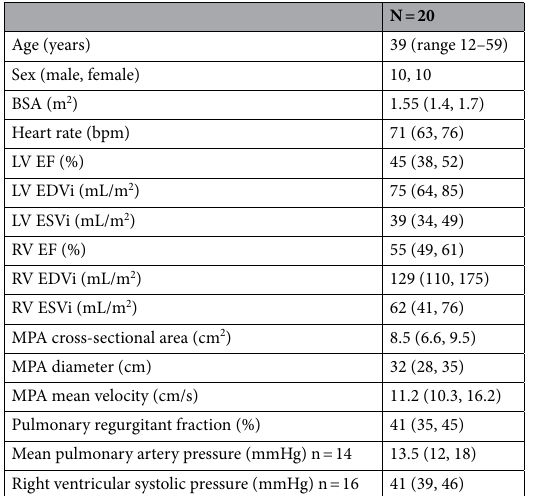
Table 1. Characteristics of 20 patients with repaired Tetralogy of Fallot. Continuous variables were expressed as median and interquartile range (lower, upper). BSA body surface area, LV left ventricular, EF ejection fraction, EDVi end-diastolic volume indexed for body surface area, ESVi end-systolic volume indexed for body surface area, RV right ventricular, MPA main pulmonary